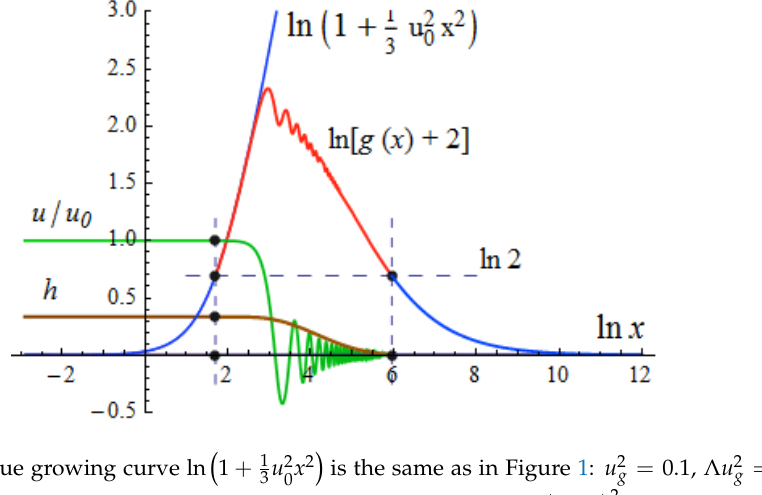
Figure 2. The blue growing curve ln (cid:18) (cid:19) 2 x g = 1. The red curve with the parameters u 2 x g max coincides with the blue one on the growing left side. However, even with a so small decrease of x g , the growing part of g ( x ) changes to a decreasing one, and a second gravitational radius x h